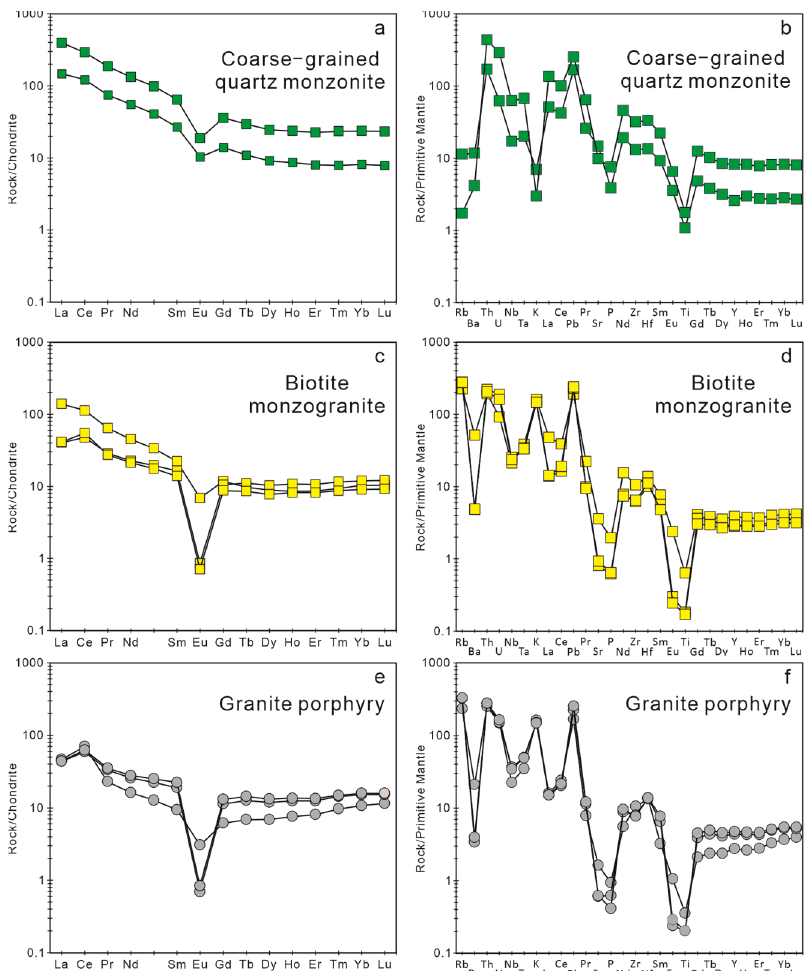
Figure 7. Chondrite-normalized REE patterns ( a , c , e ) and primitive mantle (PM)-normalized trace element spider diagrams ( b , d , f ) for the coarse-grained quartz monzonite, biotite monzogranite, and granite porphyry in the Yushulinzi pluton in the Liaodong Peninsula. The chondrite and primitive mantle values are from Sun et al. [76].